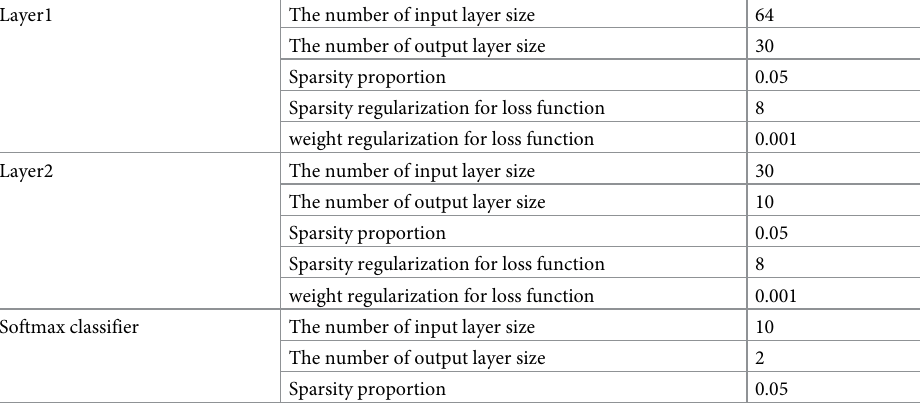
Table 2. Parameter settings for modeling